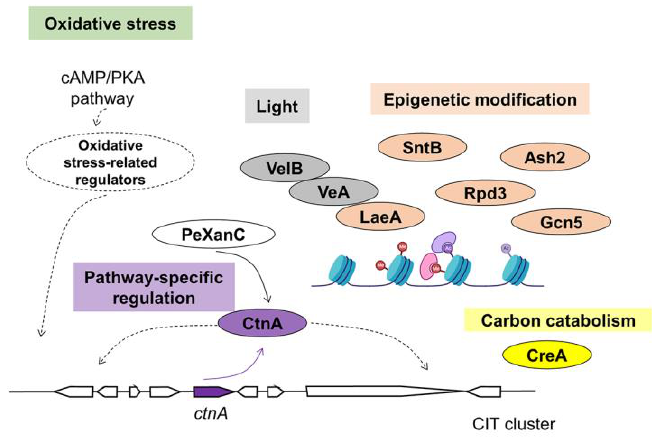
Figure 4. Regulatory mechanism of CIT biosynthesis.